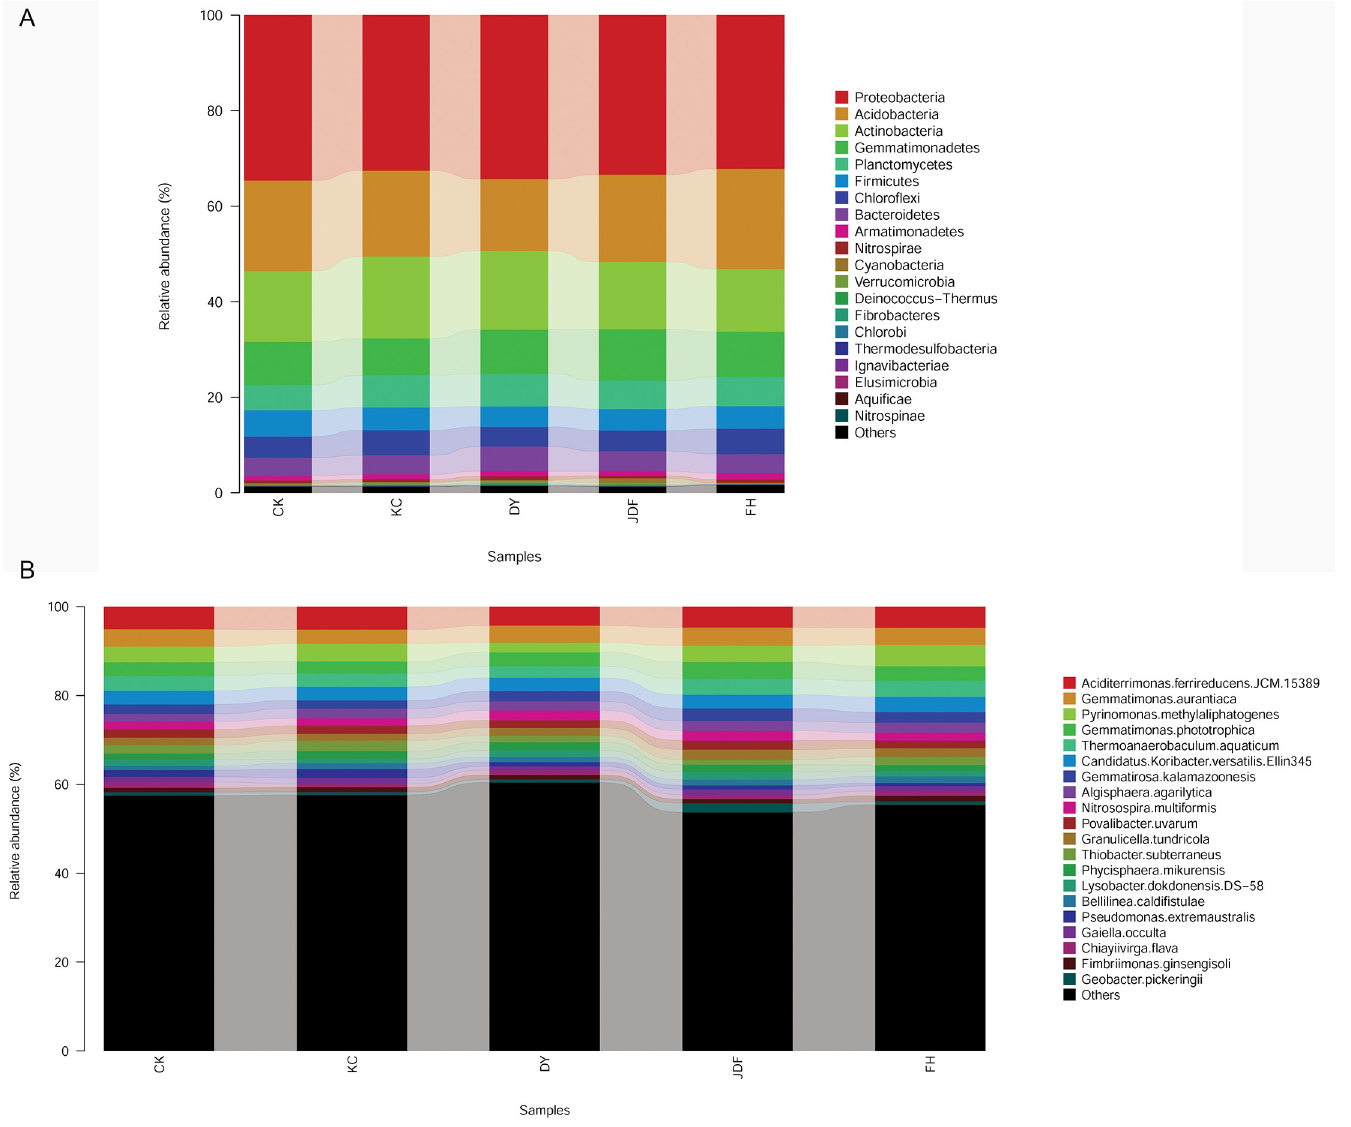
Fig 2. Bacterial community composition at the phylum (A) and species (B) level. CK, KC, DY, JDF, and FH groups indicate control, B . subtilis , B . licheniformis , B . amyloliquefacien s, and combined strains treatments,